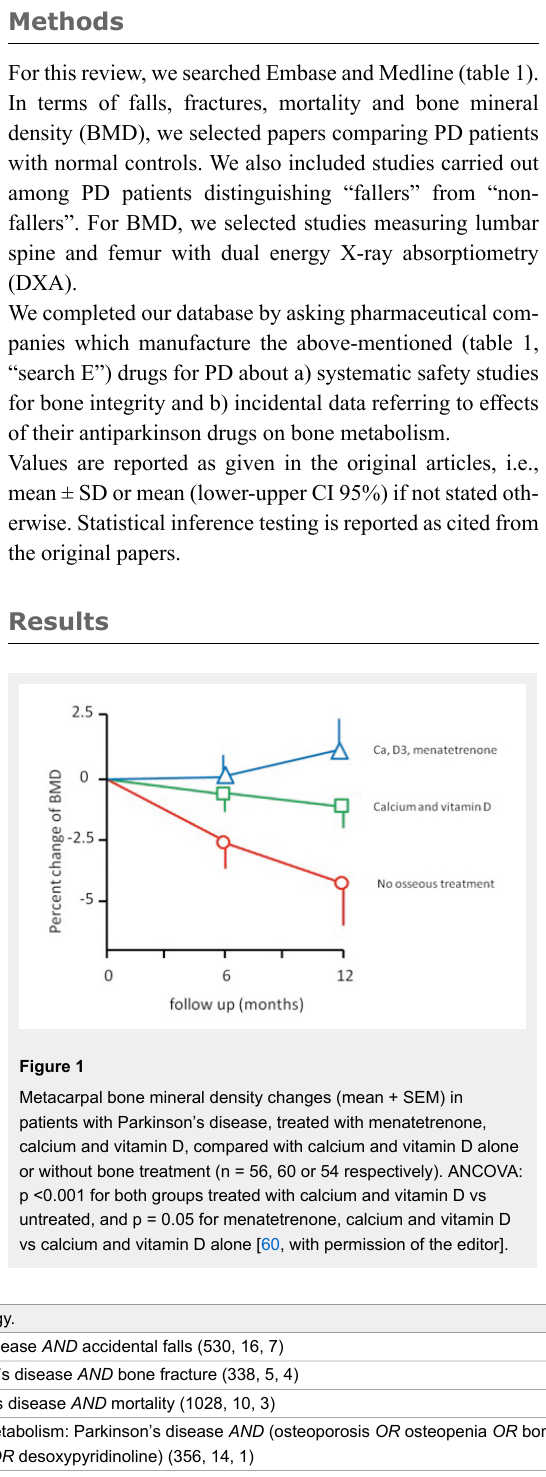
A Falls: Parkinson’s disease AND accidental falls (530, 16, 7) B Fractures: Parkinson’s disease AND bone fracture (338, 5, 4) C Mortality: Parkinson’s disease AND mortality (1028, 10, 3) D Bone density and metabolism: Parkinson’s disease AND (osteoporosis OR osteopenia OR bone mineral density OR NTx OR hydroxyproline OR undercarboxylated osteocalcin OR ICTP OR desoxypyridinoline) (356, 14, 1) E Iatrogenic effects: (L-dopa OR benserazide OR carbidopa OR bromocriptine OR cabergoline OR pergolide OR pramipexole OR ropinirol OR rotigotine OR lisuride OR quinagolide OR entacapone OR tolcapone OR amantadine OR selegiline OR rasagiline) AND (osteoporosis OR osteopenia OR bone mineral density OR NTx OR hydroxyproline OR undercarboxylated osteocalcin OR ICTP OR desoxypyridinoline) (411, 5, 13) Legend: The first number represents the hits found within Embase or Medline in November 2010, the second the papers included, the third number the papers found by other strategies like manual searches in citations of other papers. No wildcards were used for